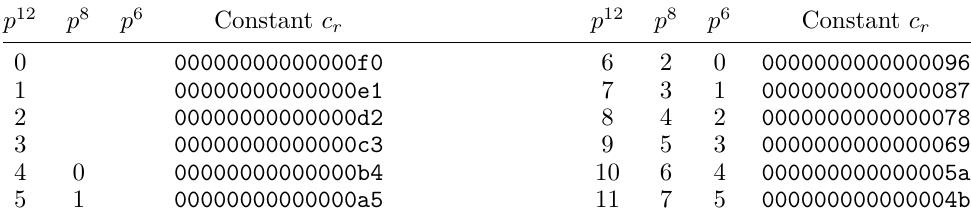
used in each round i of p a and p b r